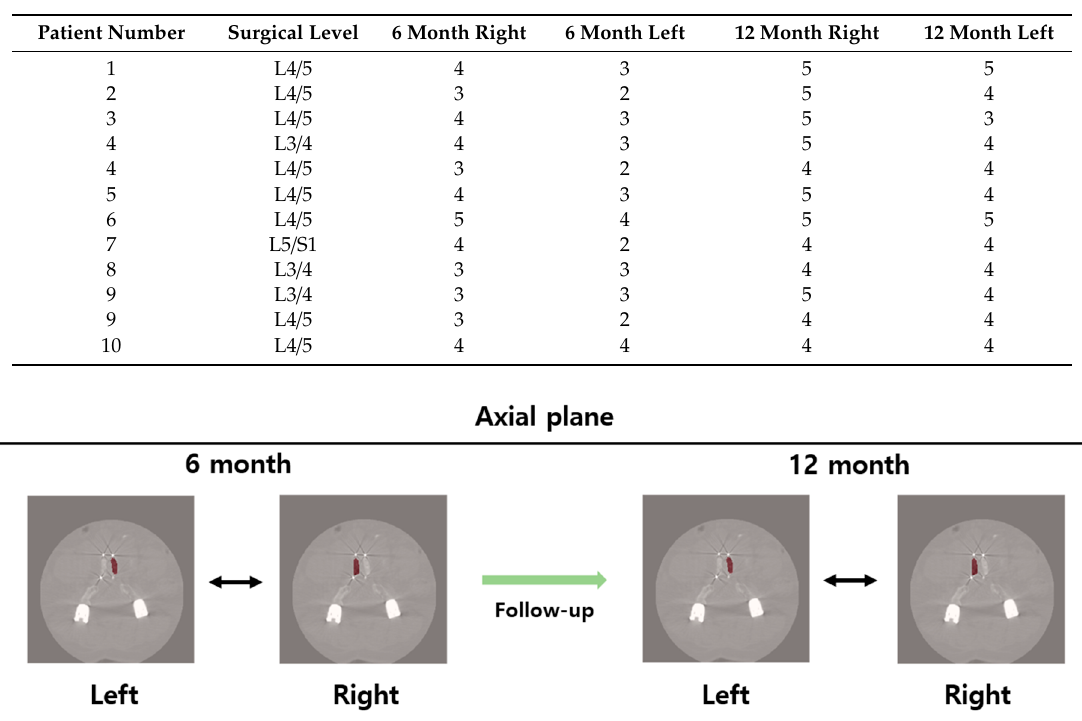
Figure 2. The follow-up spine CT for feature analysis. Overlay of red color: Region of Interest of spine.